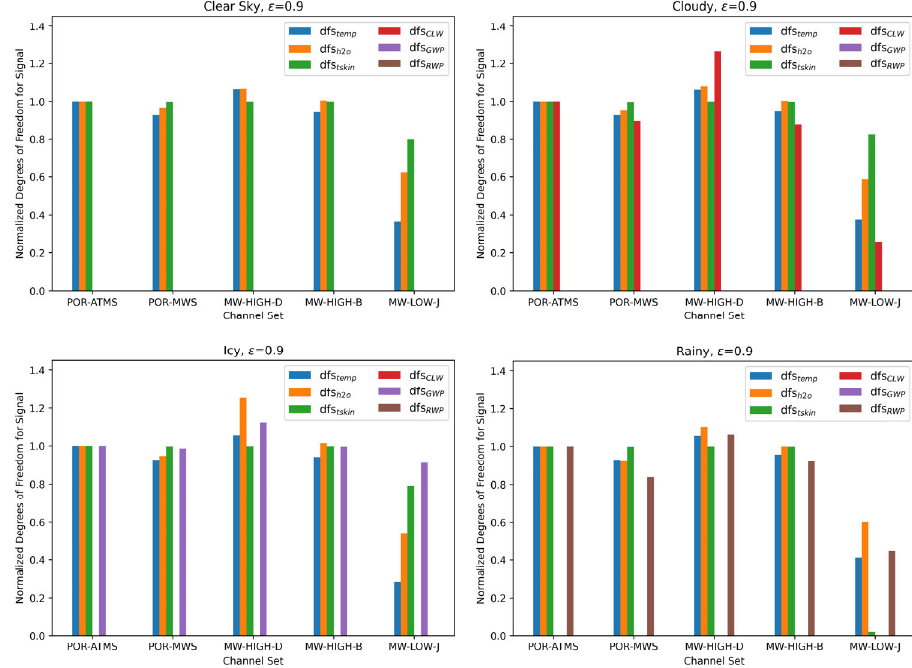
Figure 3. Same as Figure 2 but emissivity = 0.9 is used for computations. Remote Sens. 2022 , 14 , 1624